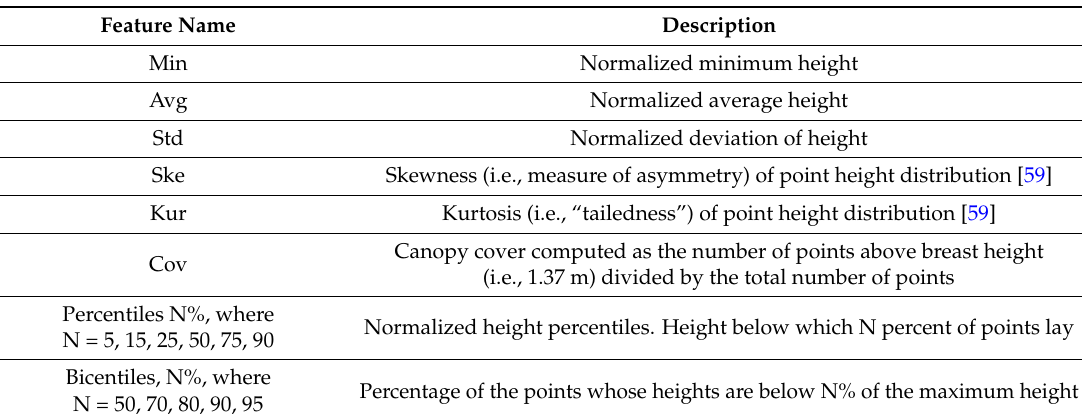
Table 7. Structural features derived from the photogrammetric point